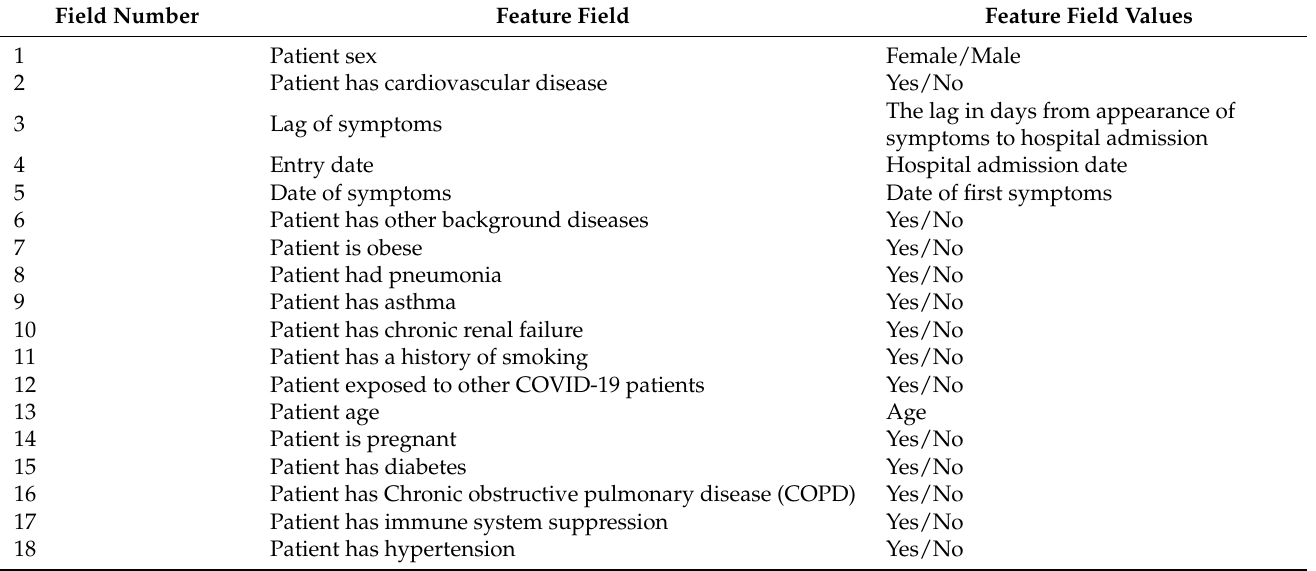
Table 1. COVID-19 dataset record feature fields.